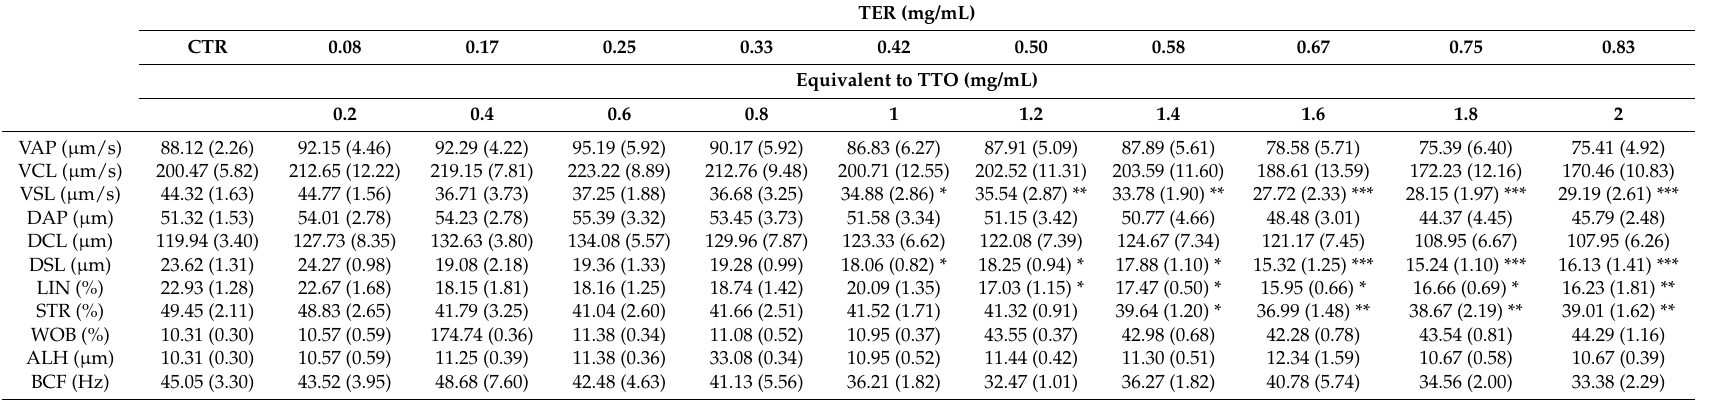
Table 3. Effects of Terpinen-4-ol (TER) on sperm kinematic parameters for samples with total motility ≥ 20%. Data are reported as Mean (standard error of the mean), n = 9. Differences were calculated by means of Dunnett PostHoc test (* = p < 0.05; ** = p < 0.01; *** = p <